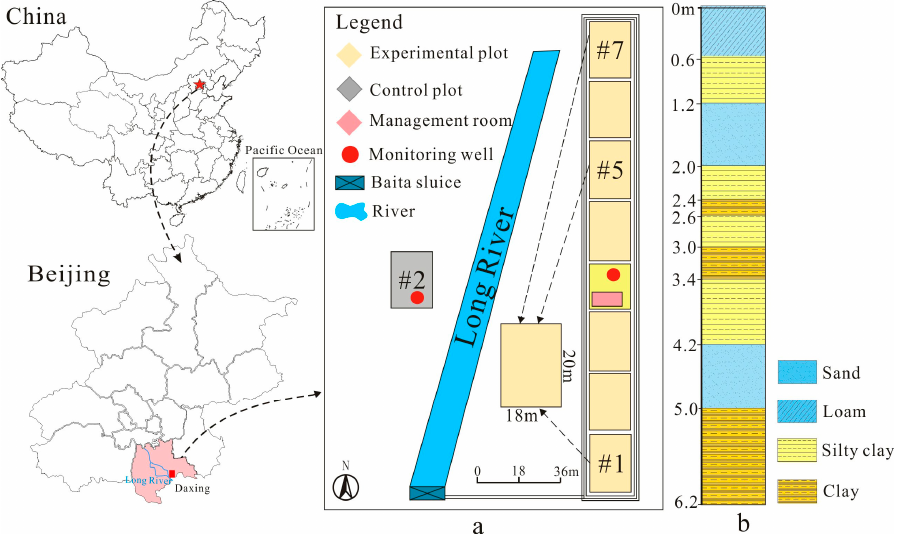
Figure 1. Schematic diagram of the study area. ( a ) the sampling plots from reclaimed water irrigation field at Long River reclaimed water irrigation area; ( b ) histogram of the sampling plot.